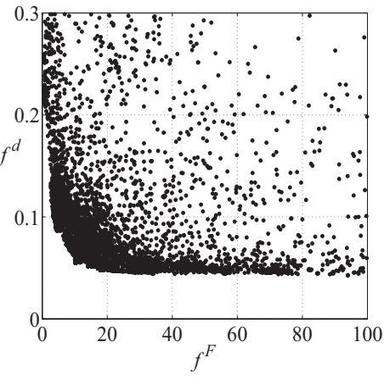
Multi-objective results using VGM model.